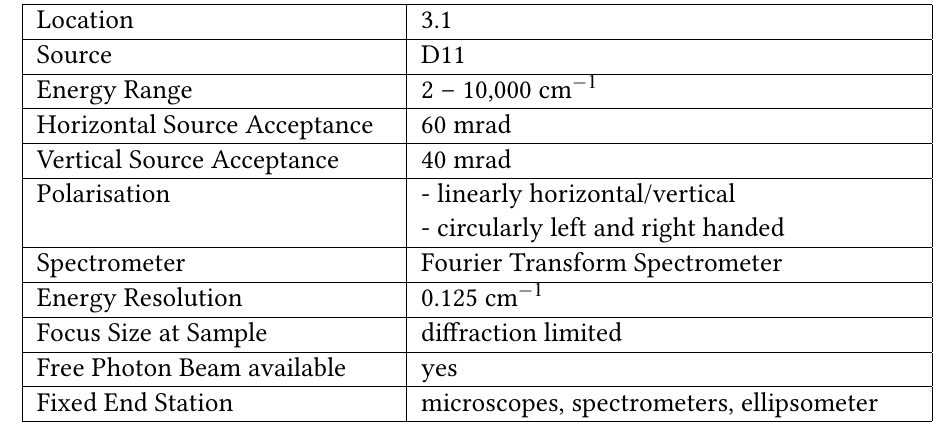
Table 1: Technical data of the IRIS